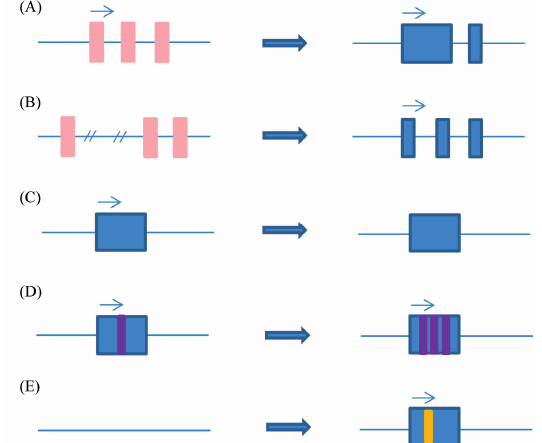
Figure 1. Possible origins of lncRNA. ( A ) acquire frame disruptions and transform into a functional noncoding RNA; ( B ) two untranscribed and previously well-separated sequence regions are juxtaposed through chromosome rearrangement; ( C ) generates either a functional noncoding retrogene or a nonfunctional noncoding retropseudo-gene, resulting from duplication of a noncoding gene by retrotransposition; ( D ) to occur neighboring repeats; ( E ) by inserting a transposable element.